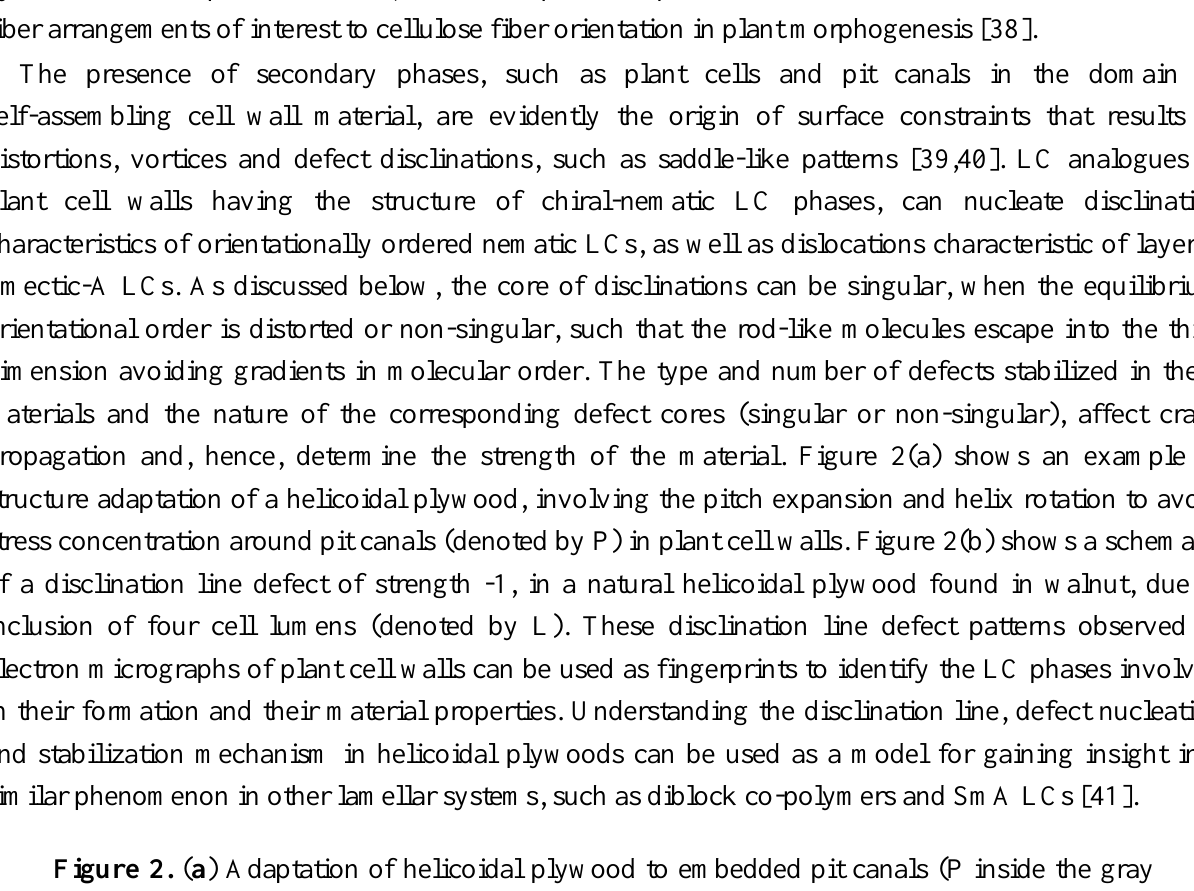
circles) by dilation of layers (shown by width changes in arc-patterns) and bending of layers (bending of arced patterns) [39] ( b ) a–1 saddle defect (denoted by *) defect in a natural helicoidal plywood due to inclusion of four (L) lumens in walnut [40] [Adapted from Rey, A.D. Liquid crystal models of biological materials and processes. Soft Matter 2010 , 6 ,